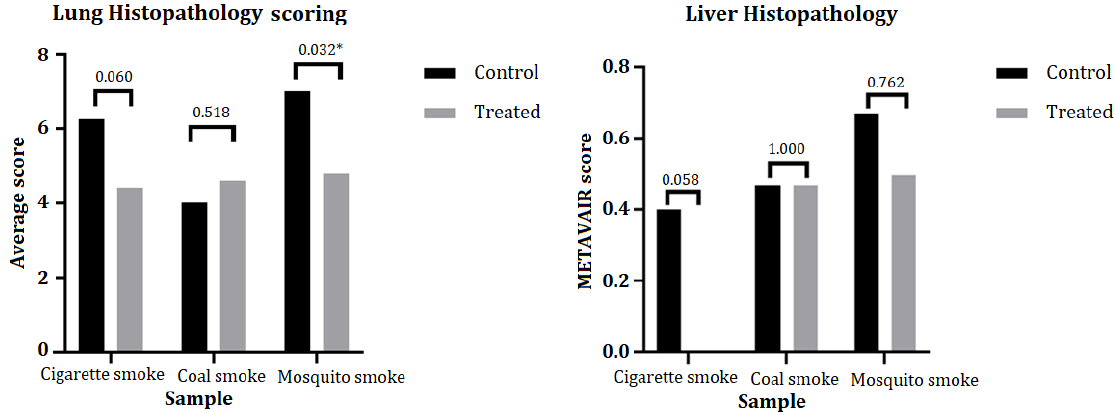
Figure 5. Histopathology scoring and statistical analysis of lung (A) and liver (B)